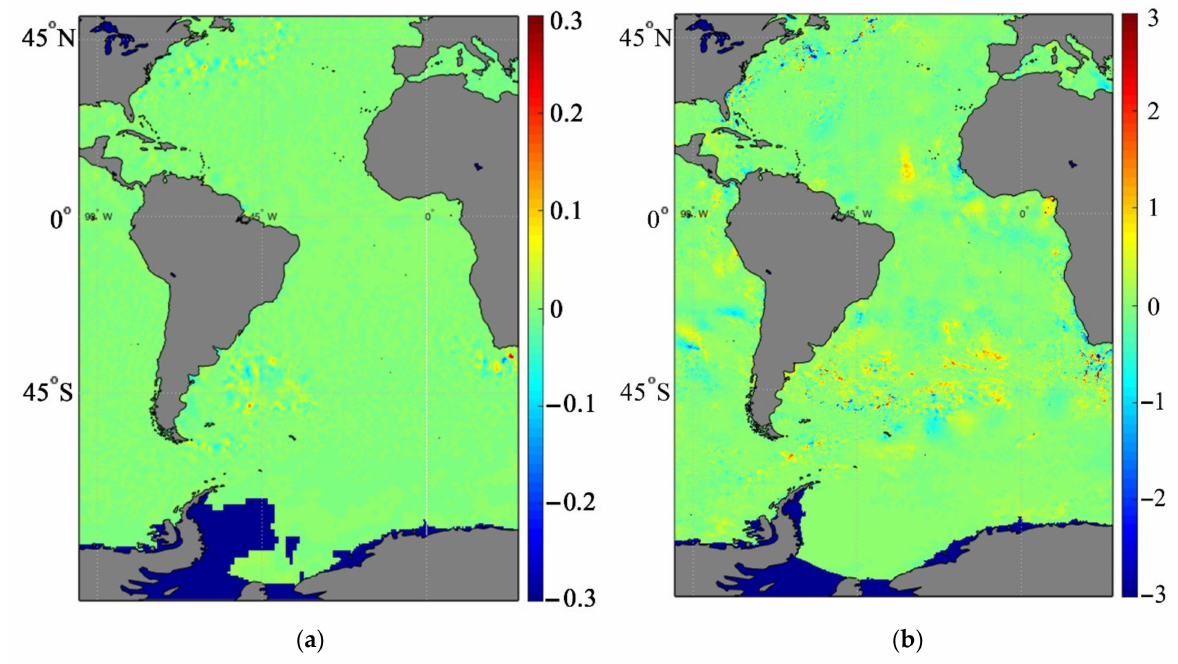
Figure 8. Fields of the observed daily differences: ( a ) SLA (m); ( b ) SST ( ◦ C) on 27 January